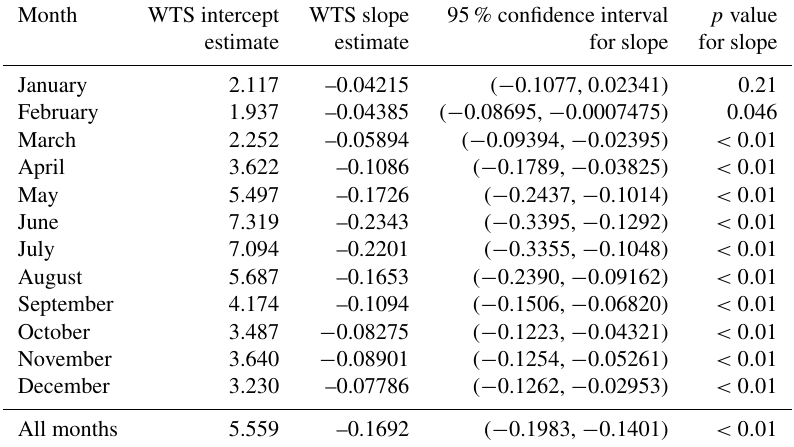
Table 1. Results from a linear regression of the spatial standard deviation, S z ( t ), on the spatial mean, z ( t ), in the Niño 3.4 region, for all t ∈ D Jan t ,t ∈ D Feb t ,...,t ∈ D Dec t , and t ∈ D t . Shown are the WTS-estimated intercept and slope coefficients for each month and for all- months-combined, and the associated model-based asymptotic 95% confidence intervals and p values for the slope estimate from a two-sided normal test. Month WTS intercept WTS slope 95% confidence interval p value estimate estimate for slope for slope January